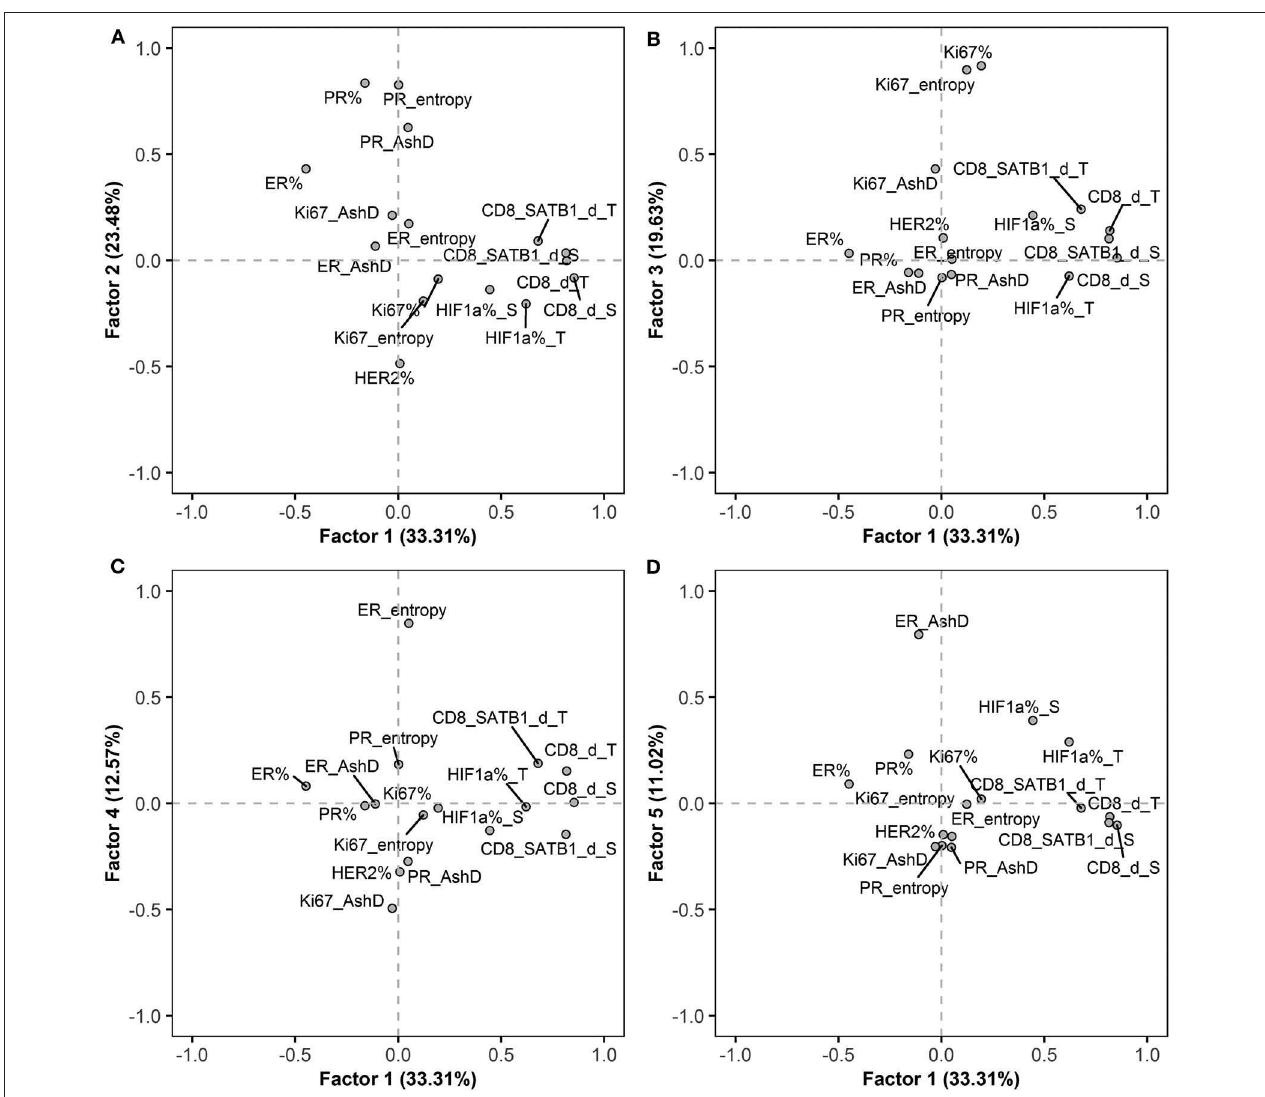
FIGURE 2 | Rotated factor pattern of the IHC indicators: AshD, Ashman’s D; d, density; S, stroma compartment; T, tumor compartment. (A) The loading of factors 1 and 2; (B) factors 1 and 3; (C) factors 1 and 4 and (D) factors 1 and 5 are plotted ( n = 101).